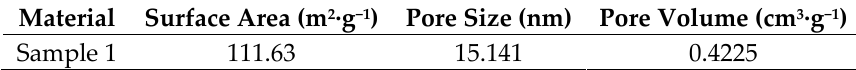
Figure 3. FE-SEM images of ( a ) Sample 1 and ( b ) Sample 2. Table 1. BET dates for the as-synthesized Sample